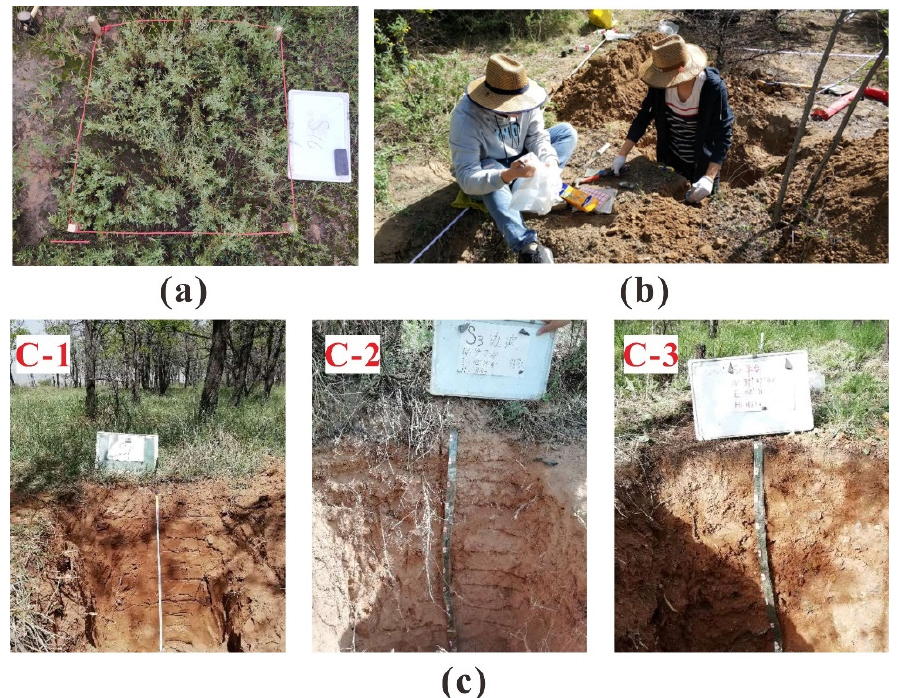
Figure 2. Some field photos of selected quadrat ( a ), soil profile excavation ( b ), and sampled soil profiles ( c ).